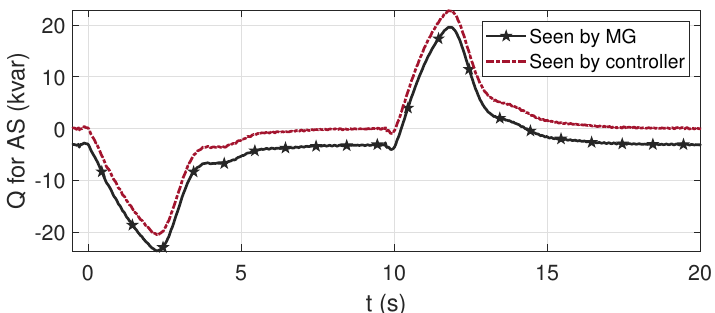
Figure 14. CHIL PV; reactive power seen by the controller (maroon) and seen by the microgrid (black).